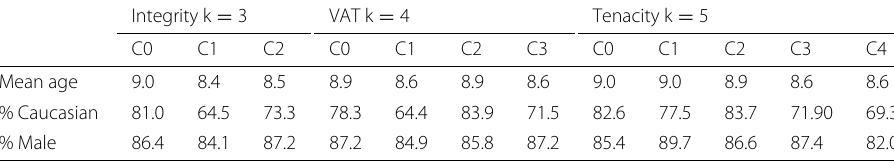
Table 4 Demographics per cluster configuration with node